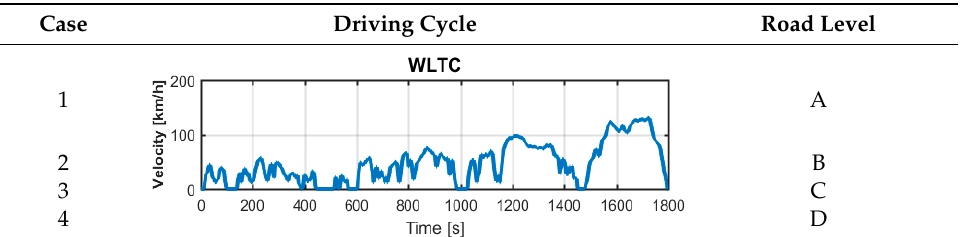
Figure 11. WTW GHG emissions from electricity consumed by regenerative suspension.